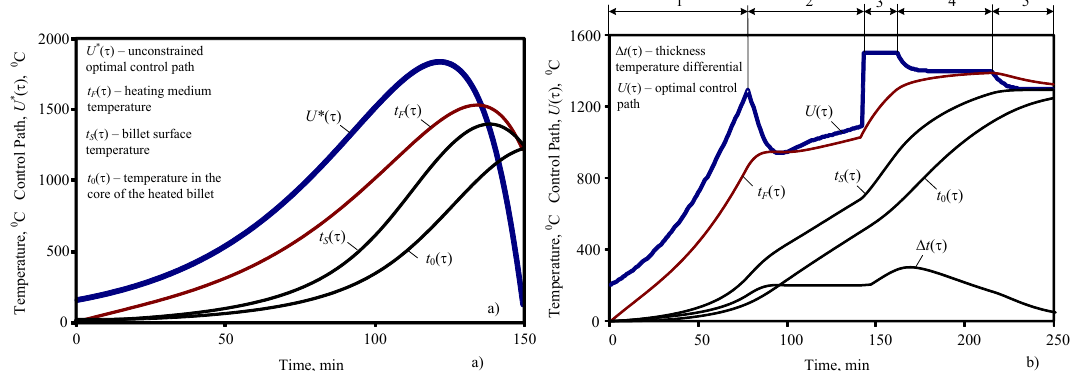
Figure 3. Calculated heating trajectories of the solved optimal control program: ( a ) without constraints; and ( b ) with